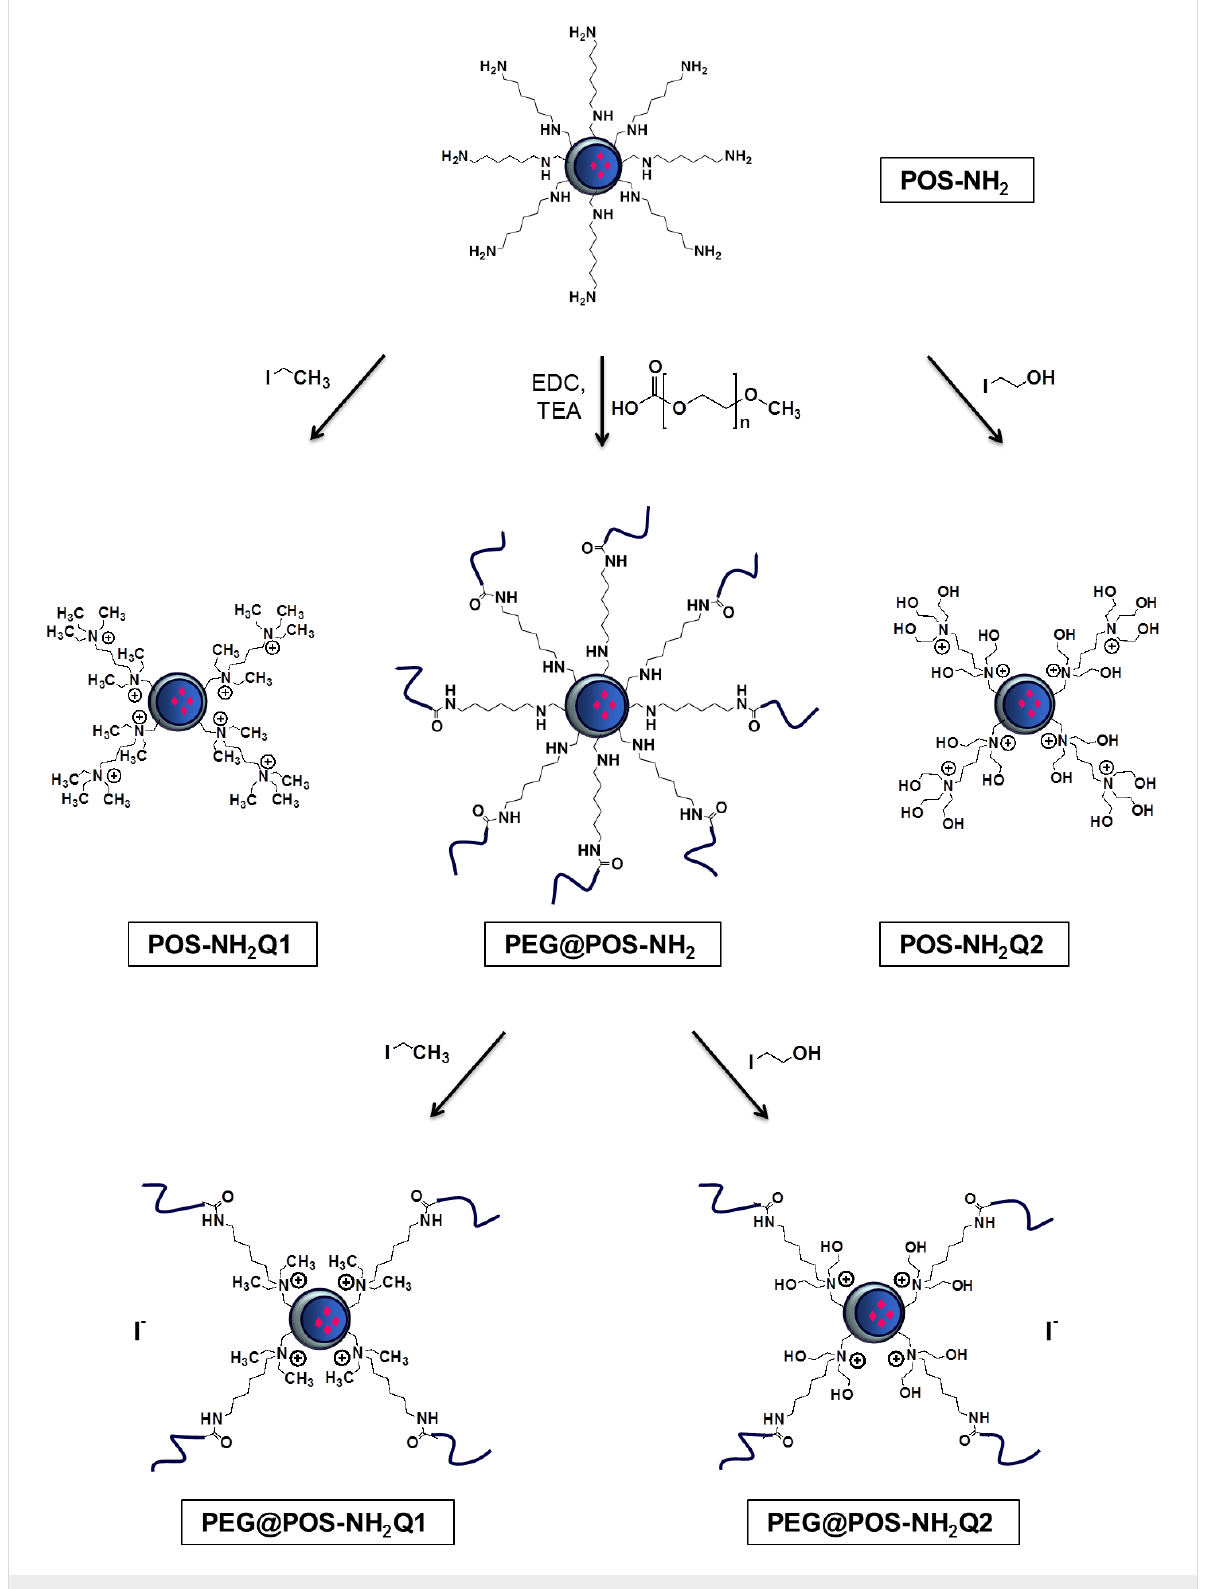
Scheme 1: Schematic illustration of the synthesis routes for the preparation of quaternized and/or PEGylated poly(organosiloxane) nanoparticles starting from AHAPS-modified